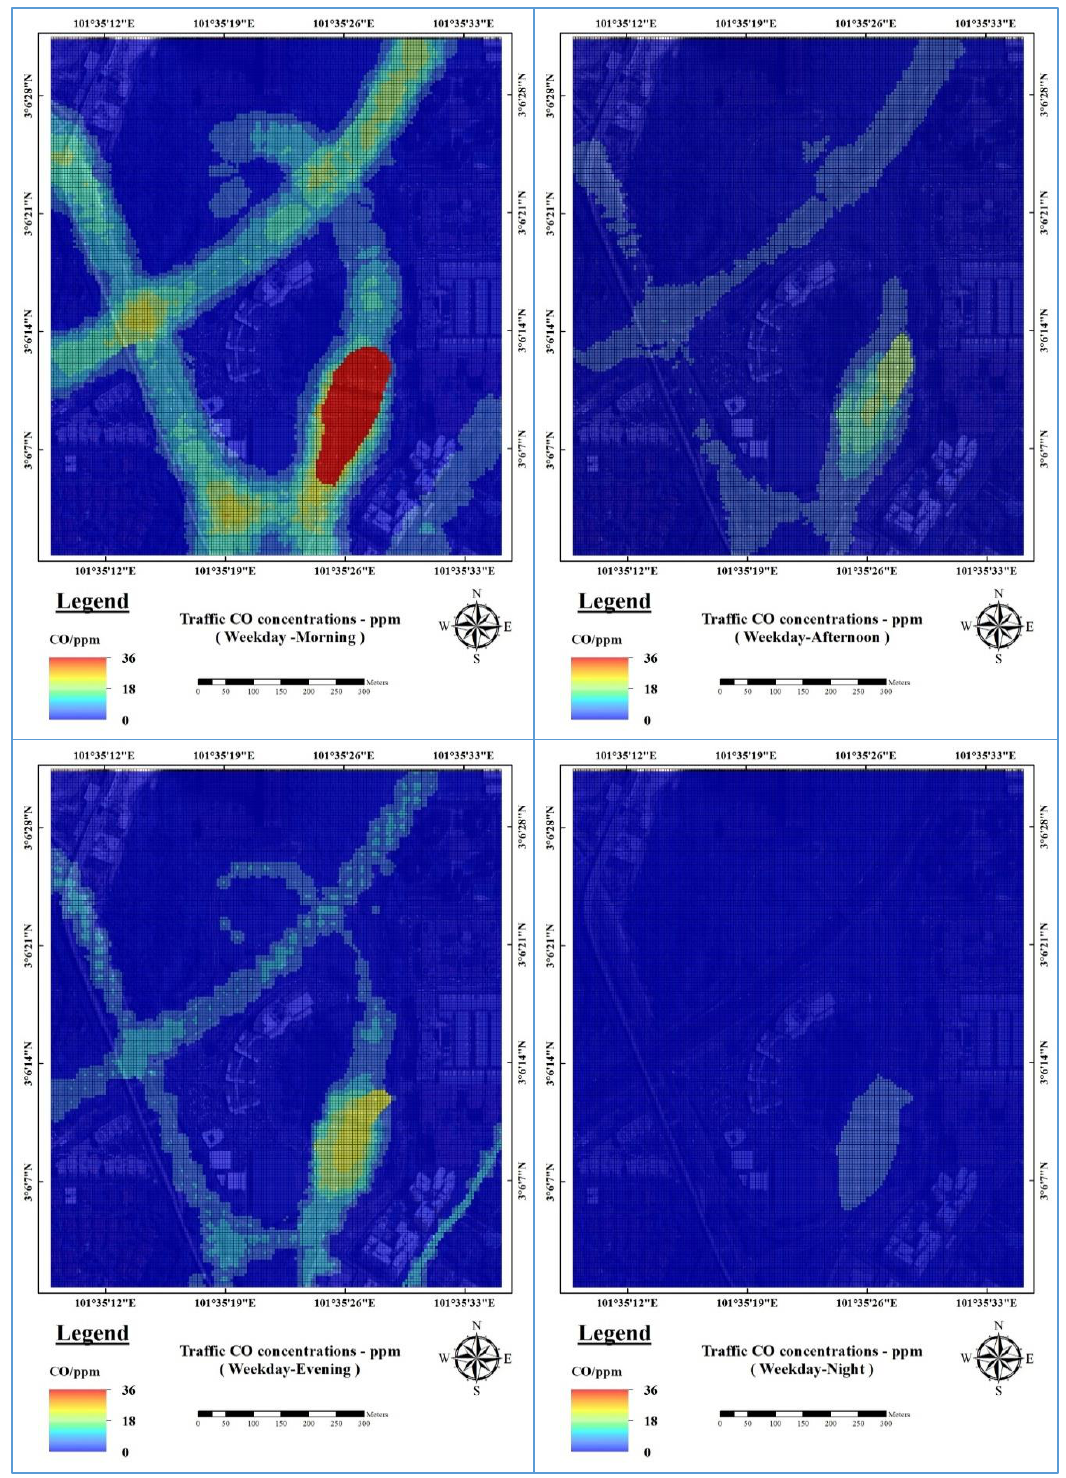
Figure 7. Prediction maps during weekdays at different times (morning, afternoon, evening and